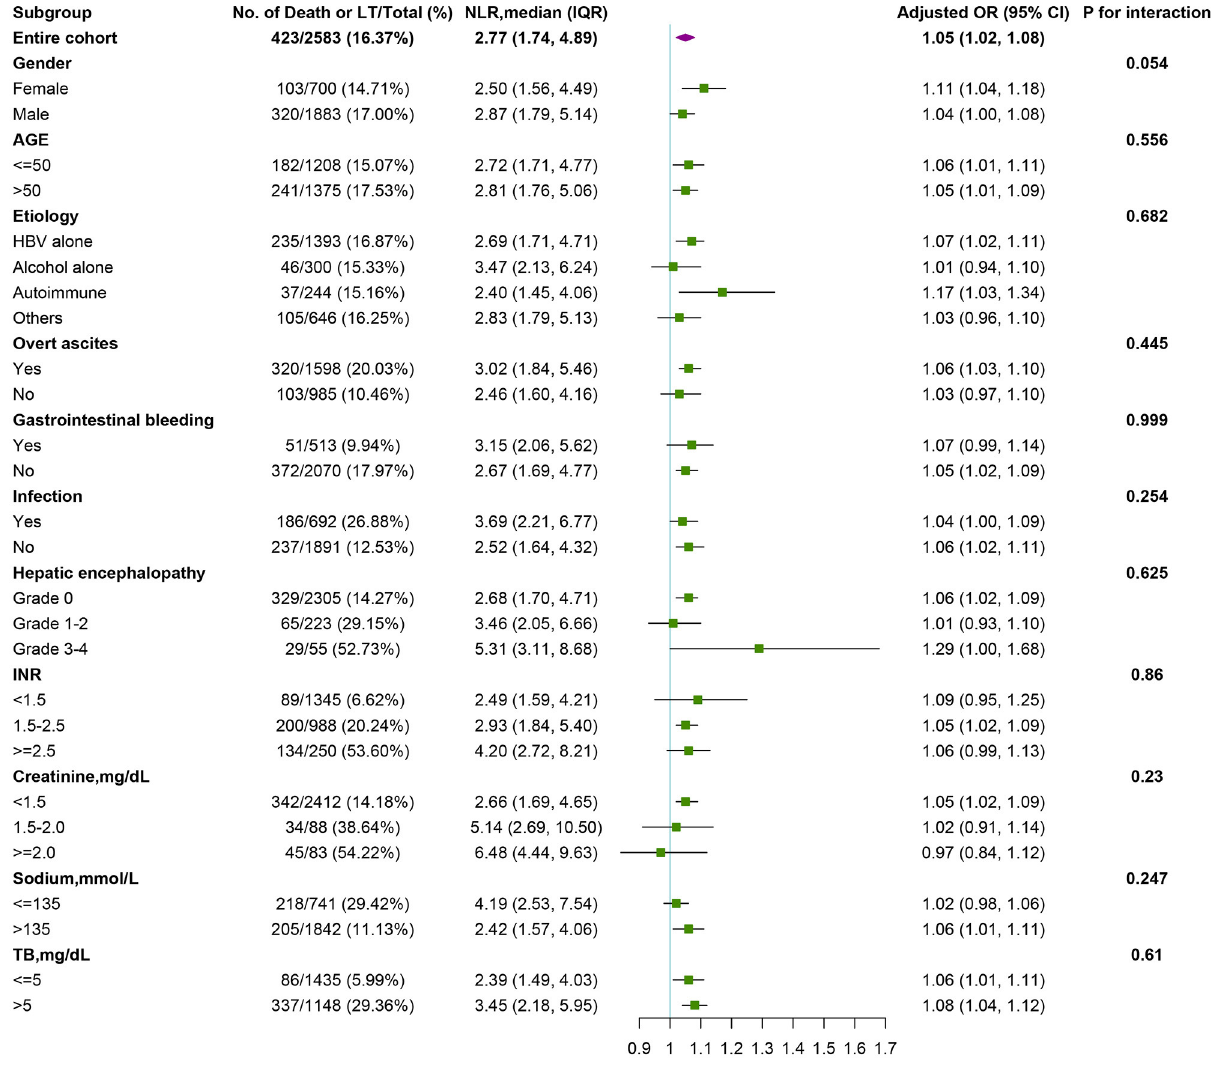
FIGURE 4 | Stratified analyses of risk of death in pre-specified and exploratory subgroups in each subgroup. The multivariable-adjusted odds ratios (95% confidence intervals) of death per unit increment in the standard deviation of NLR level is plotted for the entire cohort and according to strata of baseline covariates. The model was adjusted for age; gender; etiology (HBV, alcohol, autoimmune); cirrhosis; hepatic encephalopathy grades, infection, ascites, gastrointestinal bleeding; total bilirubin; international normalized ratio; serum creatinine. In each case, the model is not adjusted for the stratification variable. A test for interaction between NLR and strata of baseline covariates is also performed. NLR, neutrophil-to-lymphocyte